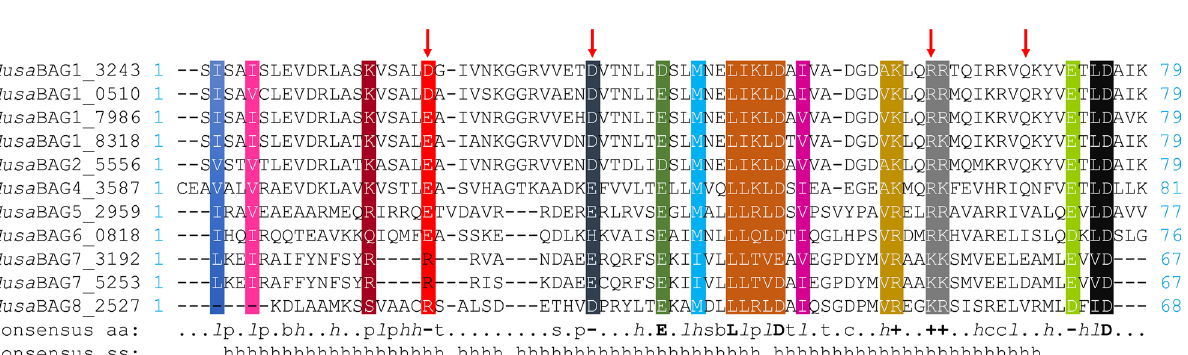
Figure 2. Multiple sequence alignment of BAG domain of MusaBAG proteins depicting conserved amino acid residues. The amino acids glutamate/aspartate (D/E), arginine (R) and glutamine (Q) (depicted as red downward arrow) are the residues possibly interacting with the ATPase domain of Hsc70 similar to the mammalian counterpart BAG1. Other characteristically conserved residues across all MusaBAGs are highlighted in